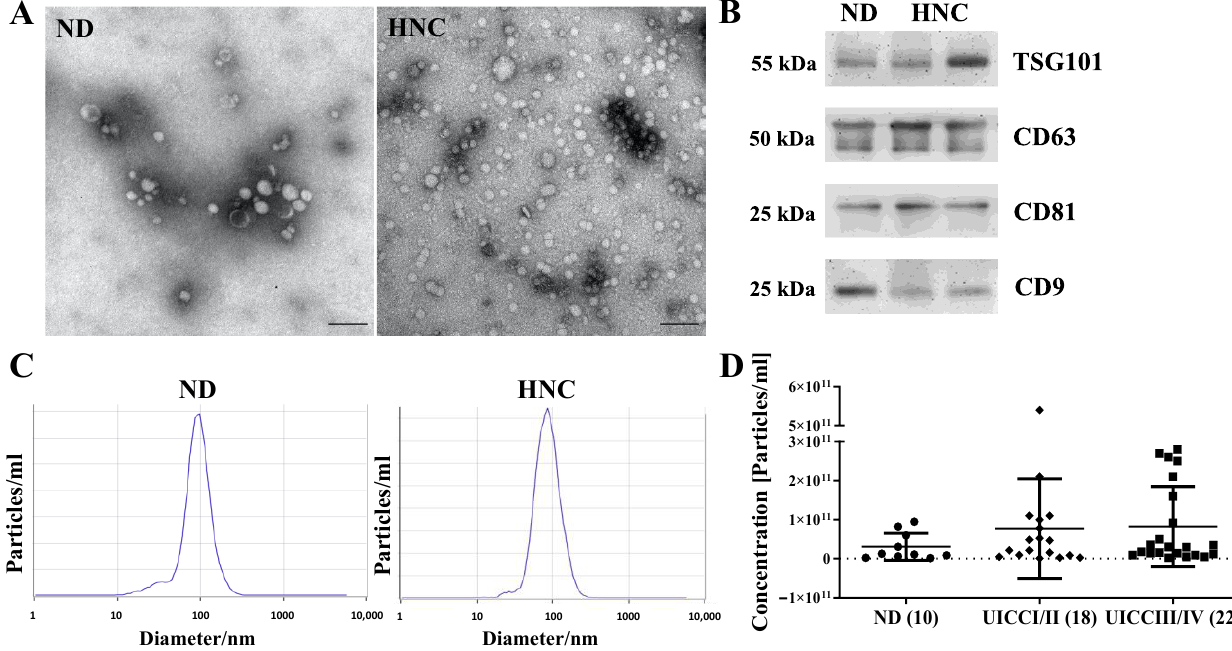
Figure 1. Characterization of sEVs from ND and HNC by morphology, protein content and size. ( A ) Representative TEM pictures from ND and HNC show the typical vesicular shape and size ranges of sEVs. The black scale bar represents 100 nm. ( B ) Western blots show sEV-specific antigens (tetraspanins and TSG101) for one ND (normal donor) and two HNC patients. ( C ) Size distribution and particle concentration of the prepared sEVs were measured by NTA. Representative pictures of the size distribution of sEVs from one ND and one HNC patient are shown. ( D ) The particle concentration is elevated in HNC patients compared to NDs ( p >